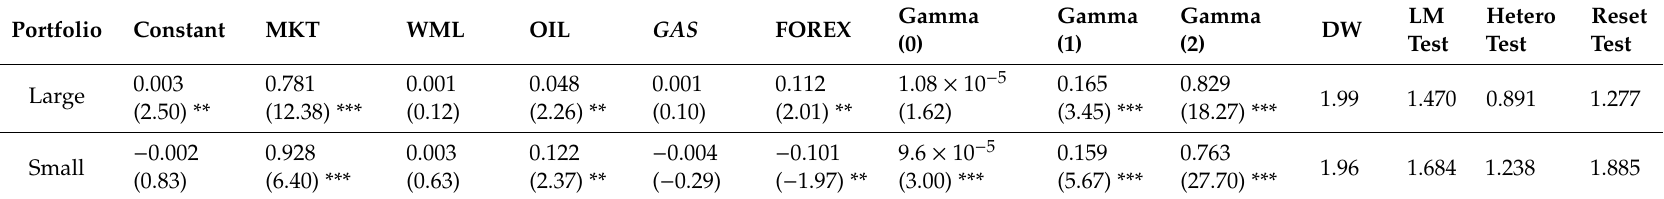
Table 3. Results for size-based